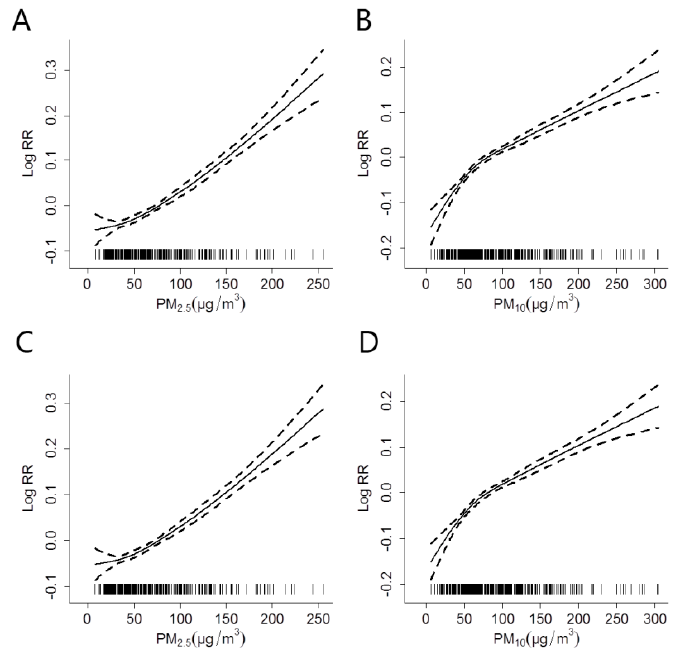
Figure 4. The concentration-response relationships for PM 2.5 and PM 10 with IHD hospitalizations at lag 0 in the cold season, after adjusting for the effect of OZONE ( C , D ) or without adjustment ( A , B ). The X-axis represents the PM concentrations ( μ g/m 3 ) on the concurrent day. The Y-axis represents the log-relative risk on the IHD hospitalizations. The solid line indicates the estimated mean change in the log-relative risk, while the dotted lines represent the 95% CI of the estimates.